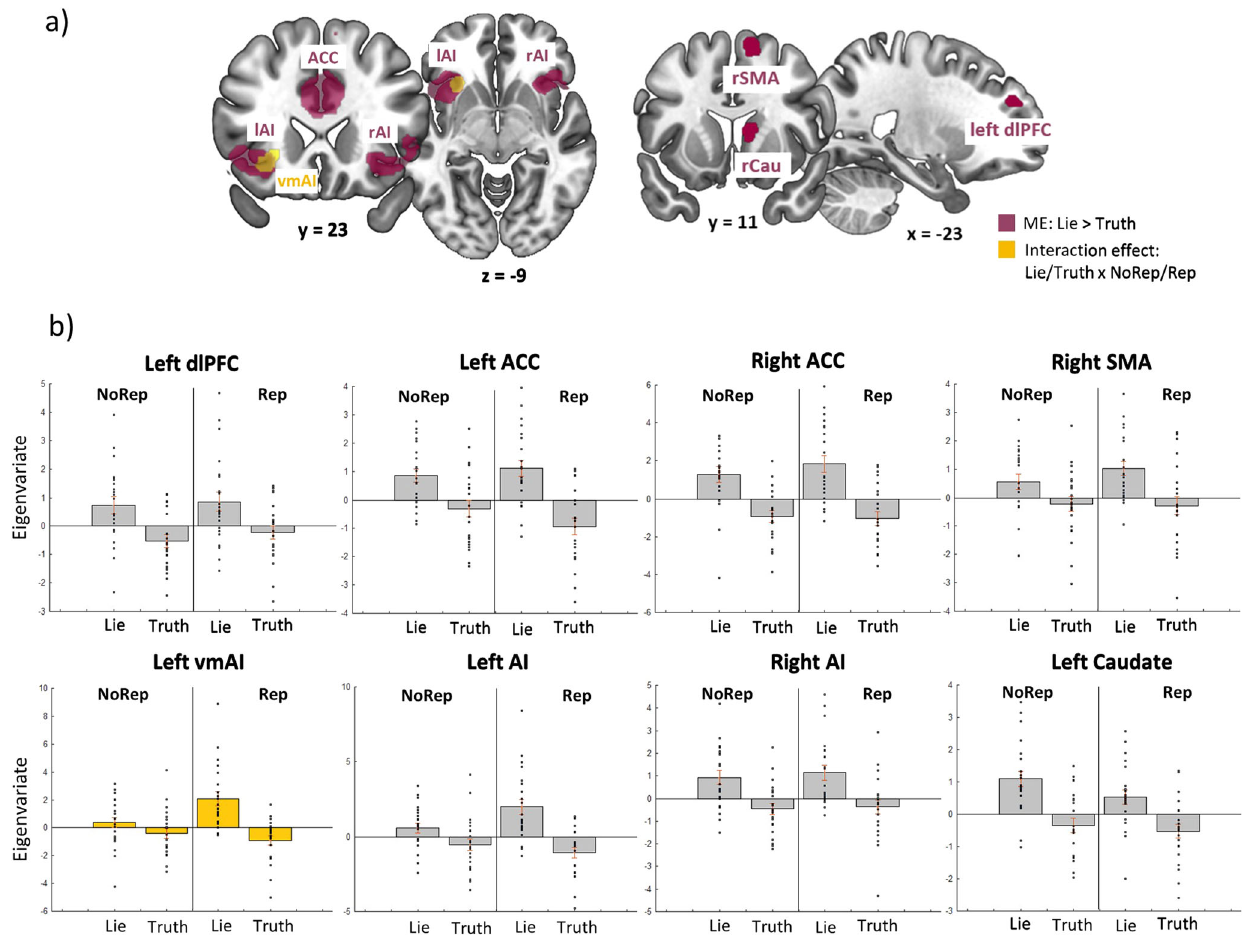
Fig. 2 Brain activation related to spontaneous lies in general and lies under reputation risk. Results of GLM1: a coronal and axial slices showing the regions active for lies vs. truths in both conditions, i.e., ACC and AI (purple map) and the left ventromedial section of the left AI for lies in the reputation risky condition (yellow map) ( N = 22). b Bar plots of regions more active for lies vs. truths. Gray bar plots for lying in both conditions, and yellow bar plots for spontaneous lies in the reputation risk condition ( N = 22). ACC anterior cingulate cortex, lAI/rAI left/right anterior insula, rSMA right supplementary motor area, dlPFC dorsolateral prefrontal cortex, rCau right caudate, NoRep no reputation risk, Rep reputation risk, BOLD blood-oxygen-level-dependent response.